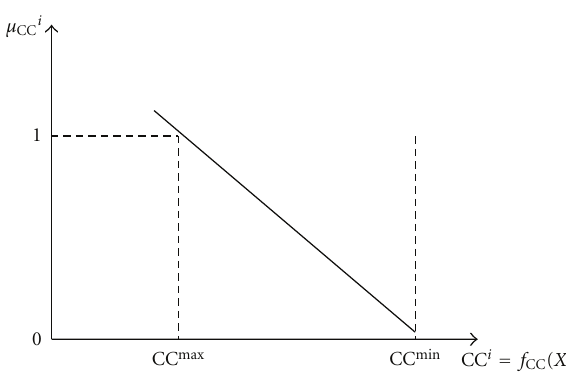
Figure 1: Fuzzy model of congestion